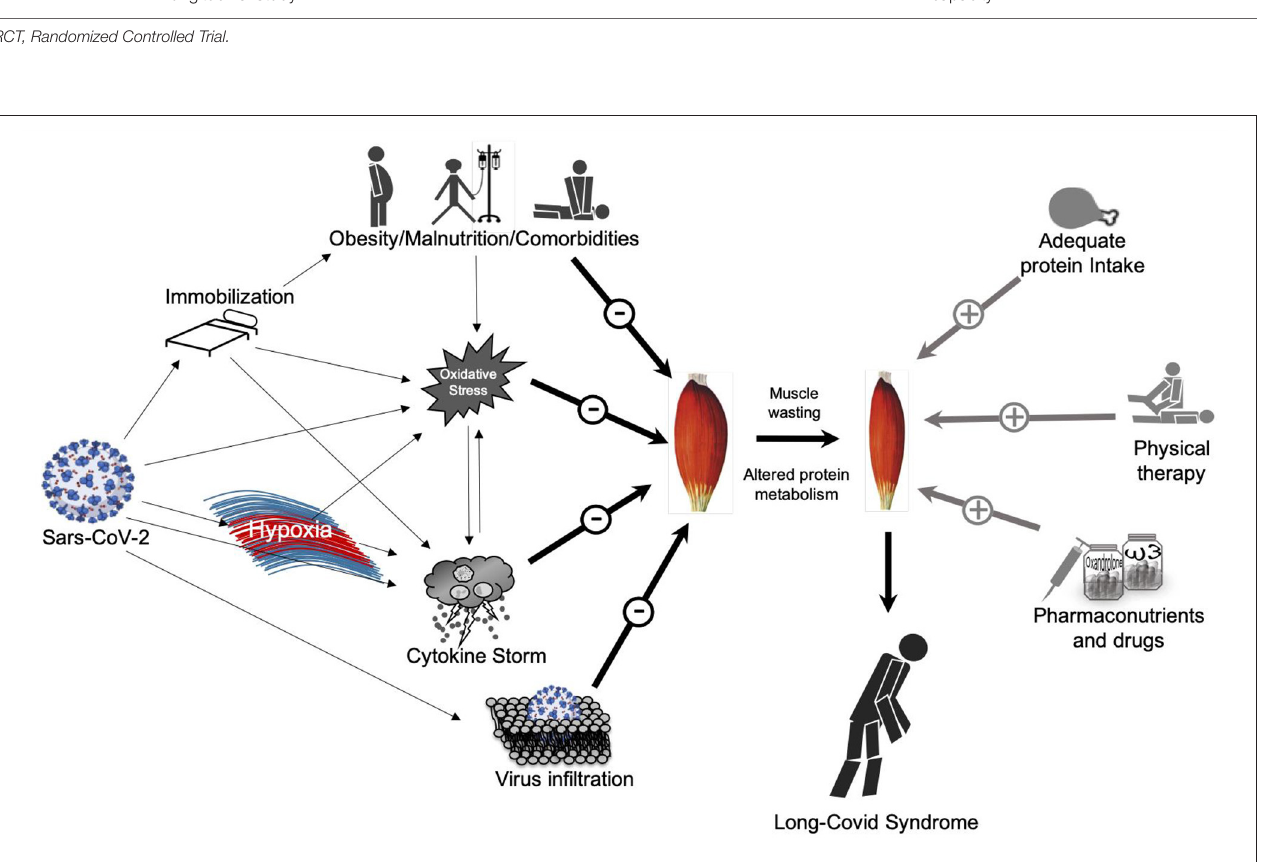
FIGURE 1 | Direct and indirect effects of Sars-CoV-2 on skeletal muscle mass and possible countermeasures. On the left side: Direct and indirect effects of Sars-CoV-2 on muscle mass potentially lead to muscle wasting and the so called “long-Covid Syndrome”; on the right-side: possible countermeasures to avoid or at least maintain muscle mass quality and